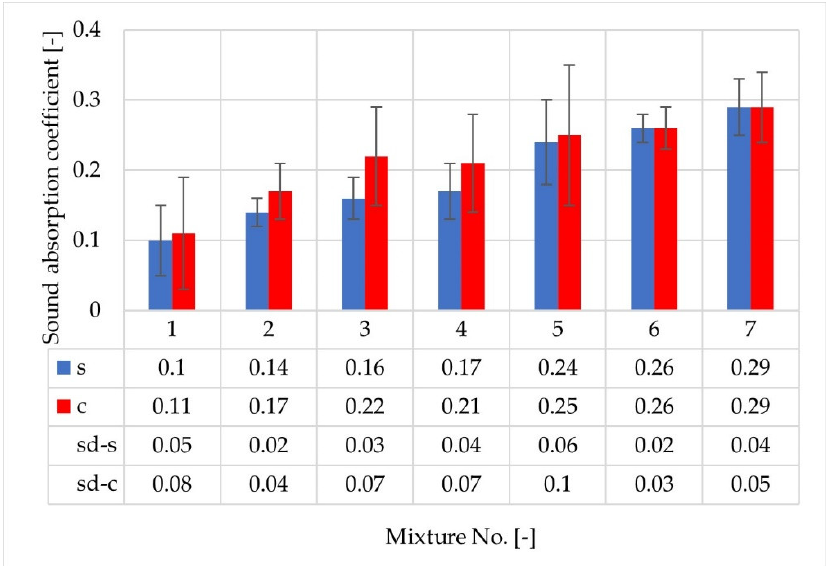
Figure 11. A comparison of the average sound absorption coefficient values obtained for test slabs (s) and cylindrical specimens (c).